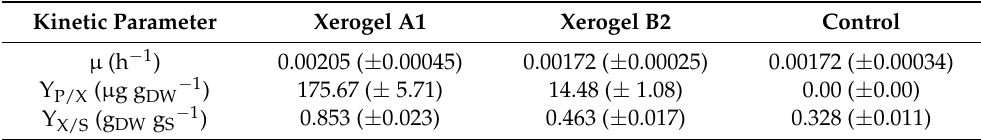
Table 2. Values of µ, Y P/X , and Y X/S obtained for the prolonged 42-day (i.e., 6 weeks) cultures of R. graeca hairy roots supported with xerogels A1 and B2 and the control culture.